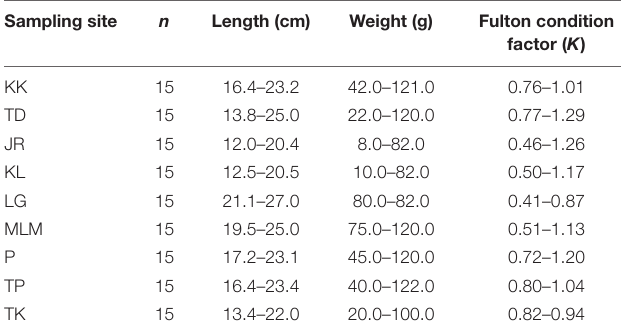
TABLE 1 | The range of wet body weight (g), fork length (cm), and Fulton condition factor of giant mudskippers collected from the West Coast of Peninsular Malaysia. Sampling site